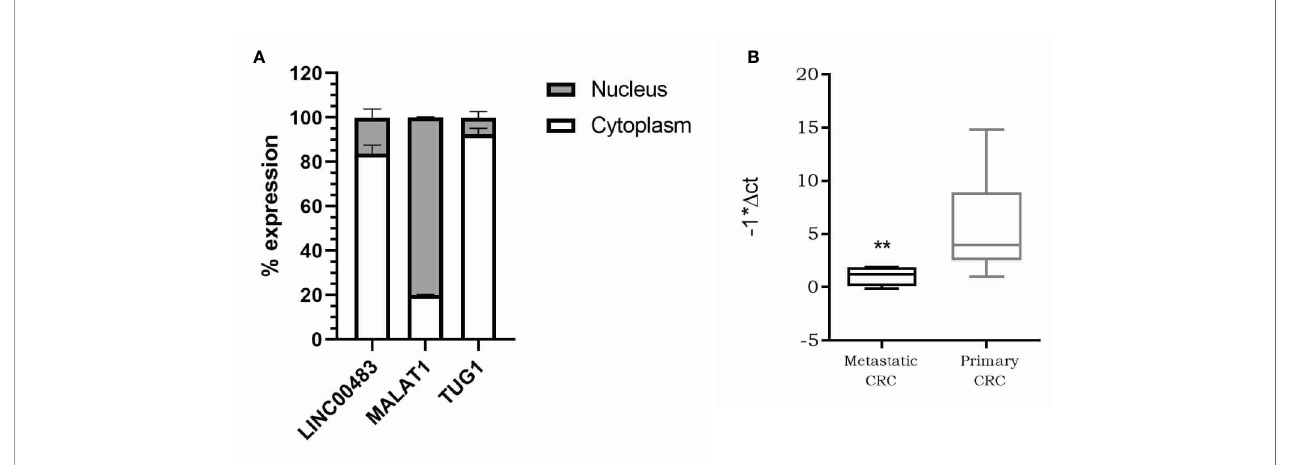
FIGURE 5 | (A) Nucleus/cytoplasm distribution of LINC00483. LncRNAs MALAT1 and TUG1 are analyzed as markers of nuclear and cytoplasmic localization, respectively; (B) Box plot showing LINC00483 expression in metastatic colorectal cancers (CRCs) compared to non-metastatic primary tumors. **p-value < 0.01.